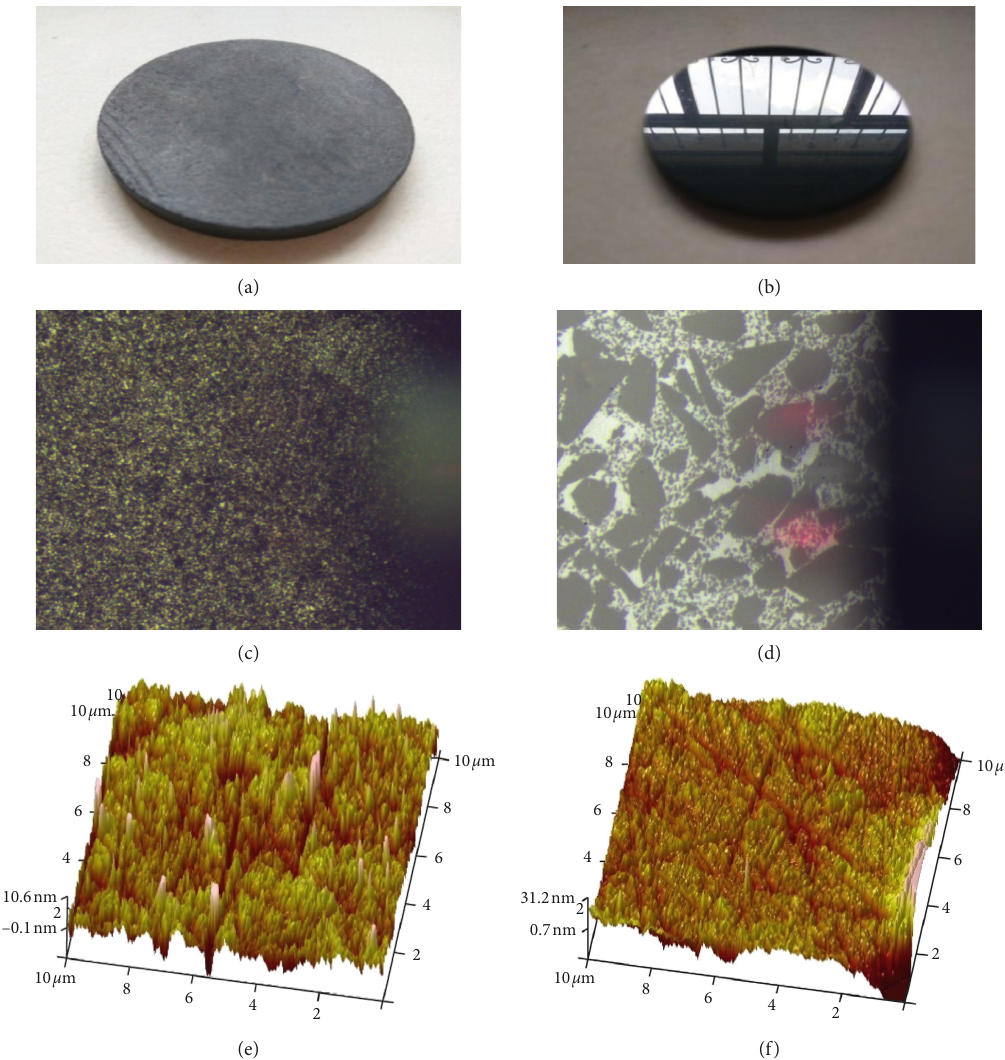
Figure 6: Morphology and microstructure of polished SiC. (a) Before polishing, (b) after polishing, (c) surface morphology before polishing, (d) surface morphology after polishing, (e) surface microstructure before polishing, and (f) surface microstructure after polishing.